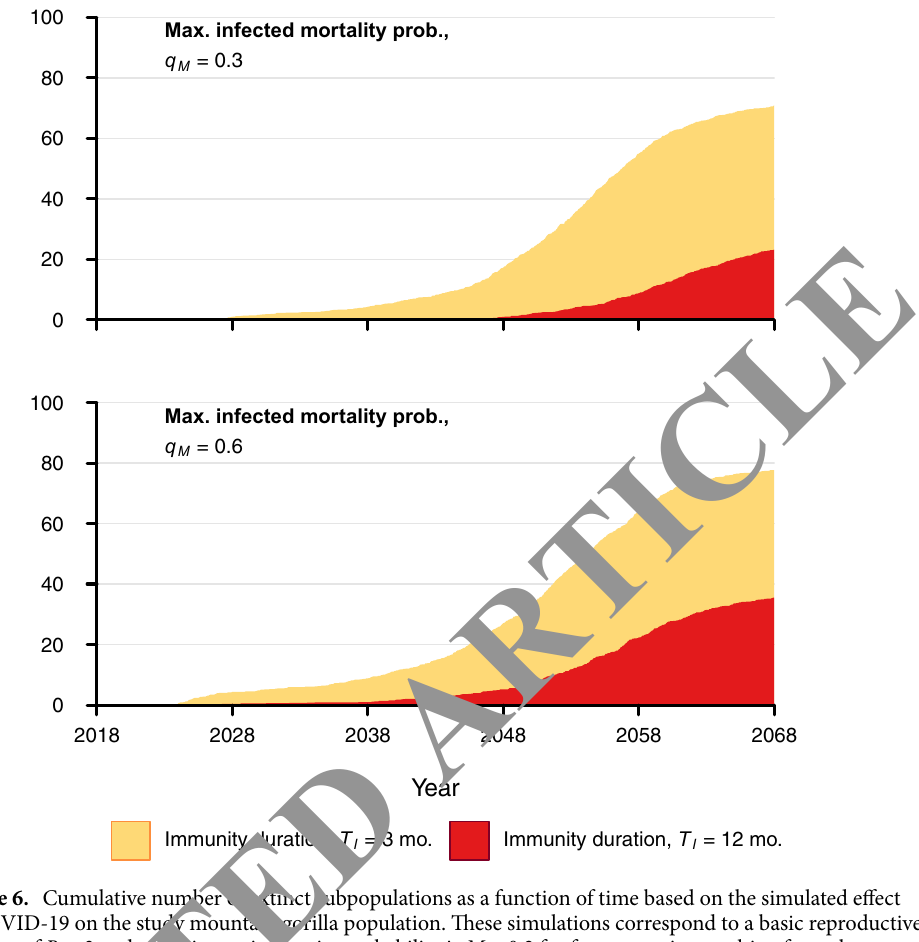
Figure 6. Cumulative number of extinct subpopulations as a function of time based on the simulated effect of COVID-19 on the study mountain gorilla population. These simulations correspond to a basic reproductive number of R 0 = 3 and a maximum immunity probability is M I = 0.2 for four scenarios resulting from the combination of an immunity duration ( T I ) of 3 or 12 months and maximum infected mortality probability ( q M ) of 0.3 or